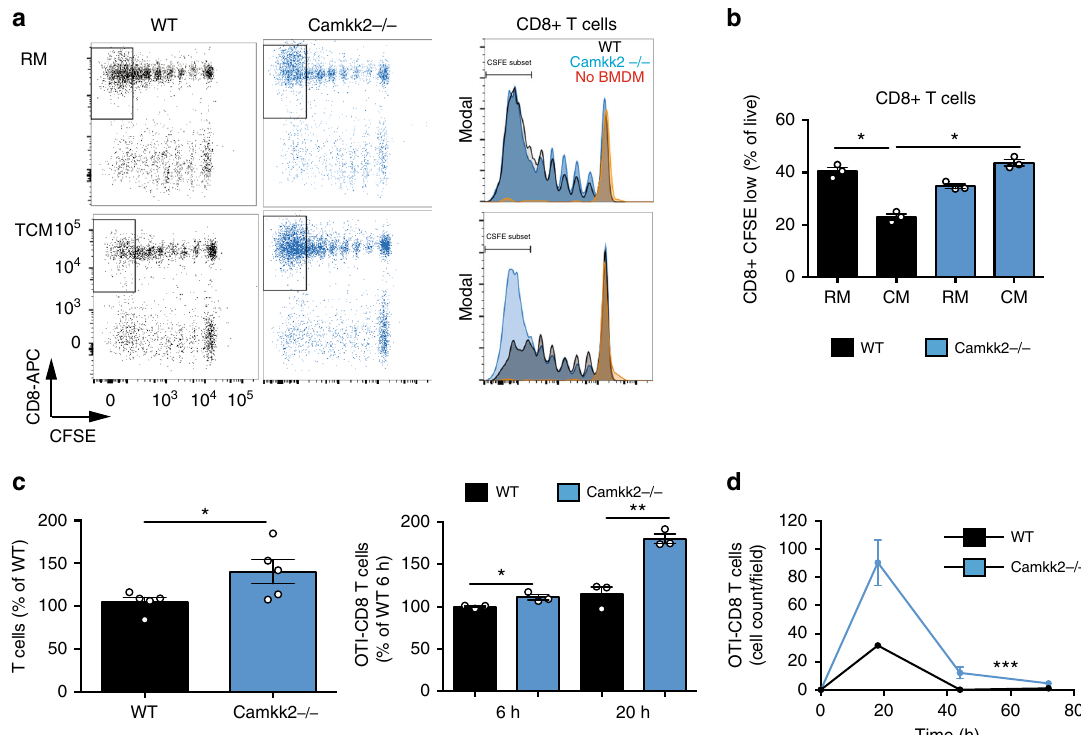
Fig. 7 CaMKK2 mediates the immune-stimulatory ability of BMDM generated in tumor-conditioned medium. a CFSE-labeled T cells isolated from wild-type mice were cultured with anti-CD3 antibody, in the presence or absence of WT or Camkk2 − / − BMDM generated in regular medium or the tumor- conditioned medium (RM and TCM, respectively). Dot plots and histograms of T cells recovered after co-culture for 72 h (Left and right, respectively). T cells were identi fi ed according to the gating strategy reported in the Supplementary Fig. 3A. b Percentage of CFSE-low CD8 + T cells (gate is displayed in the panel A dot plots). N = 3 biological replicates for each genotype. t test was used to calculate p -values. The experiment was replicated with similar results. c BMDM were generated from WT and Camkk2 − / − mice (WT and KO, respectively) in the presence of TCM. After 5 days of culture, BMDM supernates were collected and tested in a chemotaxis transwell assay for the ability to recruit T cells isolated from lymph nodes of WT mice or CD8 + OTI T cells (left and right panels, respectively). Bar graphs report mean ± SEM of T cells migrating toward BMDM supernates after 12 h and percentages of CD8 + OTI T cells migrating toward BMDM supernates at 6 and 12 h (mean ±SEM; N = 3 replicates for each genotype). t test was used to calculate p - values. These experiments were replicated with similar results. d A 3D micro fl uidic tumor on-a-chip model was used to test the effects of BMDM in E0771 tumor microenvironment (schematic of 3D on-chip model is shown in Supplementary Fig. 9). Graph reports kinetics of OTI CD8 + T cells migrating toward 3D E0771-microenvironment in fi ltrated by WT or Camkk2 − / − BMDM (mean± SEM; N = 3 low magni fi cation fi elds). Two-way ANOVA was used to calculate p -values. Asterisks refer to * p < 0.05, ** p < 0.01, *** p < 0.005, and **** p < 0.001,